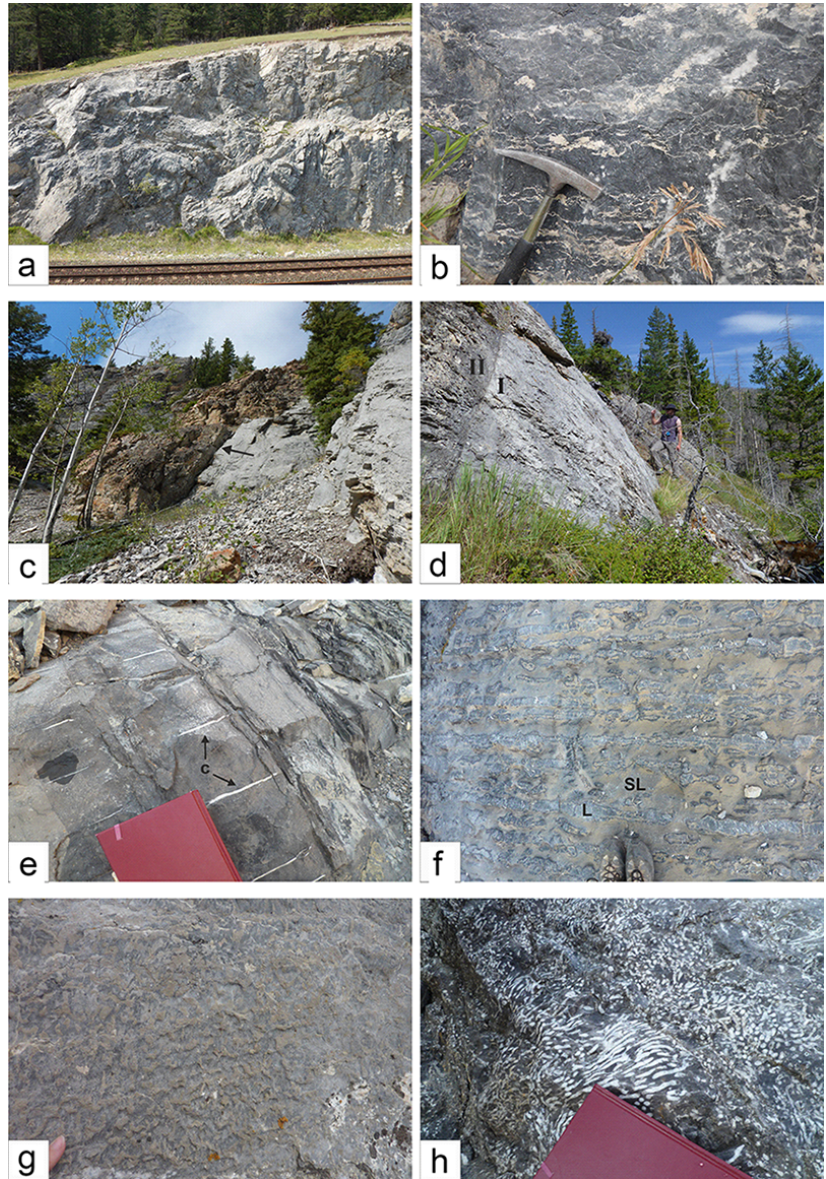
Plate A3. Field photographs from the analogue outcrops representing the five analyzed formations. (a) Massive Upper Devonian bedrock comprising the Cairn and Peechee Formation directly next to the CN railroad tracks close to Jasper. The mouse grey carbonates (mainly limestones or partially dolomitized limestones) are in close proximity to thrust faults and are pervasively foliated, jointed, and fractured, with the faults dipping mostly southwestward. This outcrop represents deposition near the margin of the SCCC. (b) Dark grey, massive, and coarsely bedded partially dolomitized carbonates of the Cairn Formation at outcrop Gap Lake. This outcrop is also part of a thrust sheet and is overlain by Mississippian Exshaw shale. (c) Dolomitized parts (black arrow) along a major fault at sample location Mount Greenock, recognized by a medium-brown colouration. (d) Steeply inclined, massive medium-grey carbonates of the Peechee Formation (I, on the right), laterally juxtaposed against dark grey off-reef carbonates and marls of the Perdrix Formation (II, on the left) at outcrop Mount Greenock northeast of Jasper. The exposed carbonates are predominantly limestones and represent deposition near the margin of the SCCC. (e) The Perdrix Formation at outcrop Nigel Peak contains interbedded, dark grey, massive limestones and dark grey shales. The bed thickness ranges from 20 to 50cm. Note the approx. 15cm long calcite-filled vugs (“c”) perpendicular to the bedding. At outcrop Nigel Peak the Devonian carbonates crop out in the riverbed (rocks dipping northeastward) and belong to the Fairholme Complex. (f) The dark grey limestones with brown silty layers in the Mount Hawk Formation at outcrop Nigel Peak contain abundant diagenetic bedding. Both Perdrix and Mount Hawk represent the “off-reef”. (g) Dark grey, massive limestones of the Perdrix Formation at outcrop Gap Lake showing an irregular, weathered surface. (h) The Grotto Formation at outcrop Nigel Peak consist of fine-grained, dark grey dolostones with abundant disphyllid corals preserved in growth